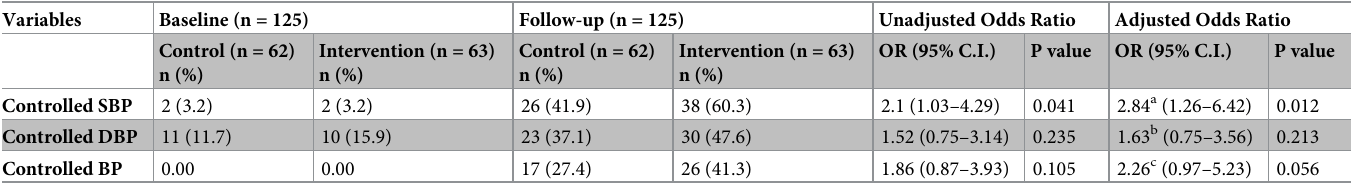
Table 5. Sensitivity analysis of intervention effects on outcome